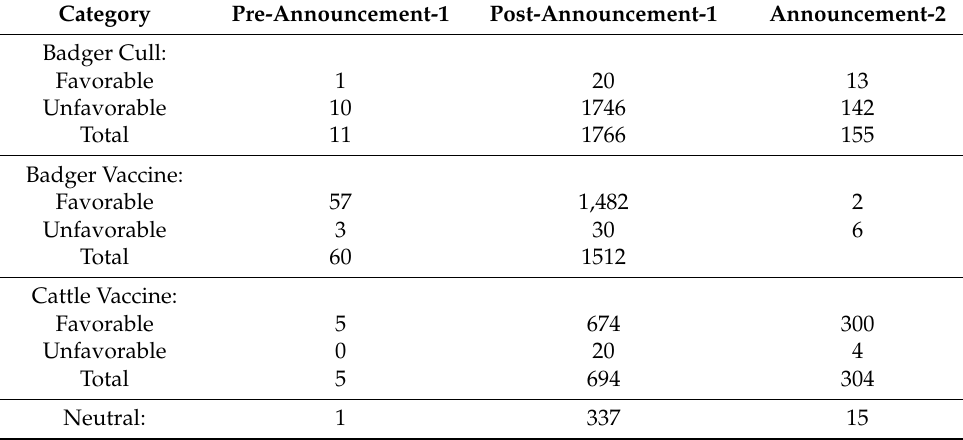
Table 2. Numerical categorization of digital and social media